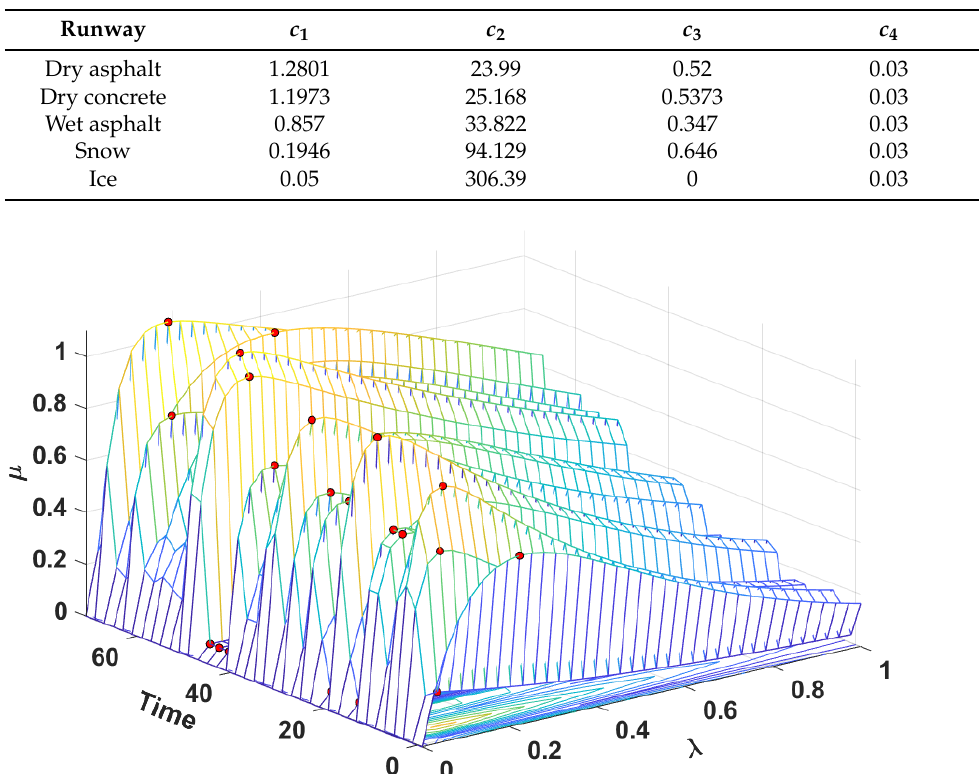
Table 2. Parameters of several types of runways.